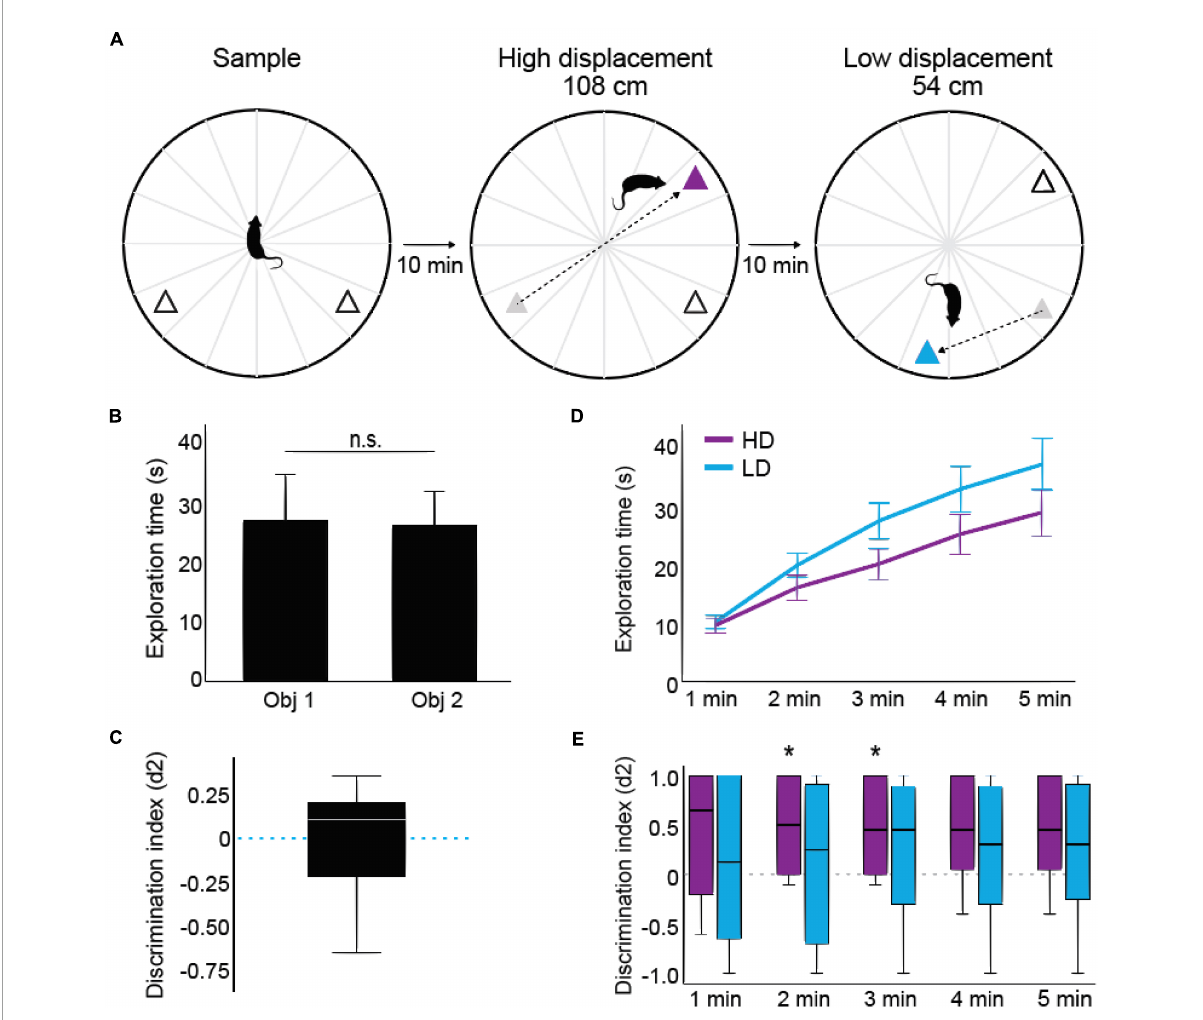
FIGURE2 Experimental design and behavioral performance. (A) Schematic illustration of the object recognition task with high and low spatial displacement tests. In the sample phase, rats explored two identical objects (triangles) in a circular open field (118 cm diameter) for 5 min. In the high and low displacement tests, one object was spatially displaced by 108 cm and another by 54 cm, respectively. (B) Total exploration time of each object during the sample session. Bars represent means and error bars represent SEM. (C) Discrimination index among objects [(tDO – tSO)/(tDO + tSO)] calculated during the sample session. The whisker plot shows the distribution of discrimination index values, where the white line depicts median, black bars represent upper and lower quartiles, and error bars represent values outside the middle 50%. Dashed line depicts chance values (i.e., rats devoted the same time to exploring both objects). (D) Minute-by-minute cumulative analysis of the time of object exploration during the high and low spatial displacement tests (purple and cyan, respectively). Lines depict means and error bars represent SEM. (E) Minute-by-minute cumulative analysis of the discrimination index in HD and LD tests (purple and cyan, respectively). Black lines depict medians, bars represent upper and lower quartiles, and error bars represent values outside the middle 50%. Asterisks indicate p < 0.05 against zero (i.e., chance levels; Wilcoxon signed-rank test), n = 8